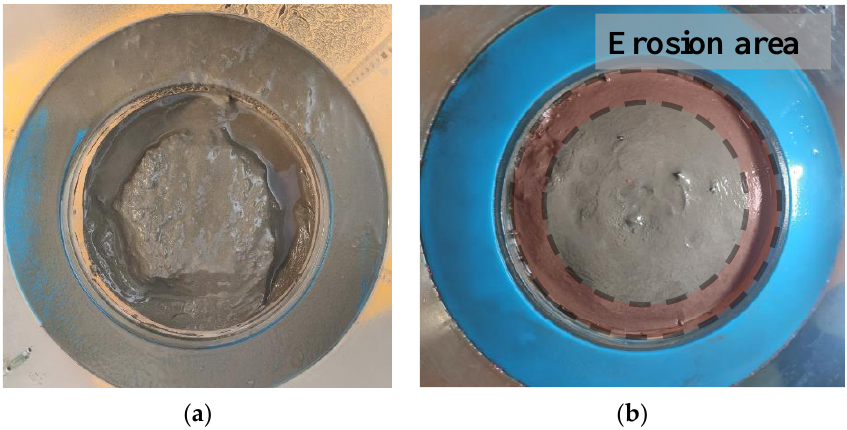
Figure 12. Typical test results obtained from simplified scour resistance tests. ( a ) Low strength solidified soil ( b ) High strength solidified soil.